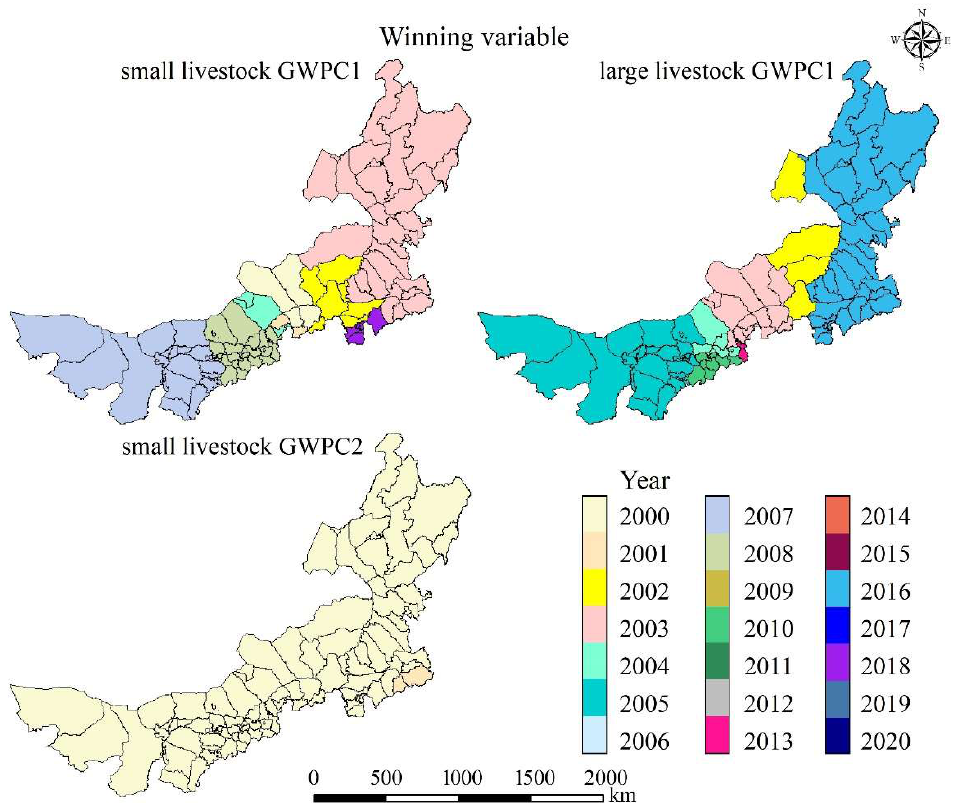
Figure 6. The winning variables of the GWPC1 − 2 of small livestock population ( left ) and GWPC1 of large livestock population ( right ).